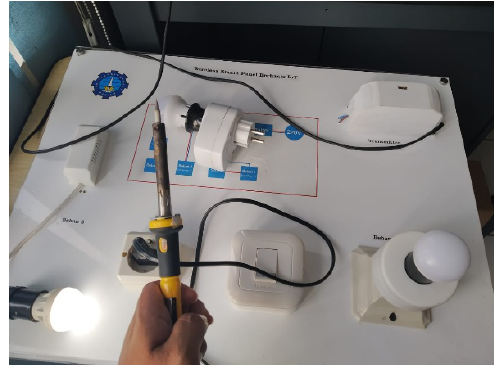
Figure 9. The circuit after overloading